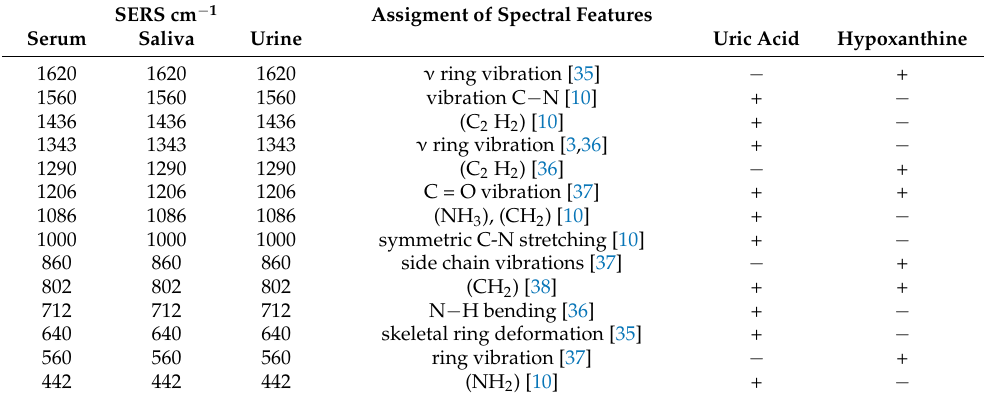
Table 1. Assignment of SERS of uric acid, hypoxanthine and 3 kDa filtration of bodily fluids.